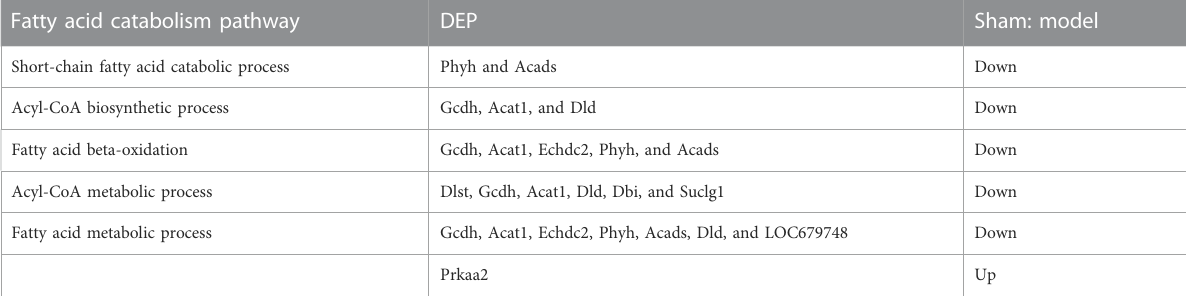
TABLE 2 DEPs of Sham: model enriched in fatty acid catabolism pathways. Fatty acid catabolism pathway Short-chain fatty acid catabolic process Acyl-CoA biosynthetic